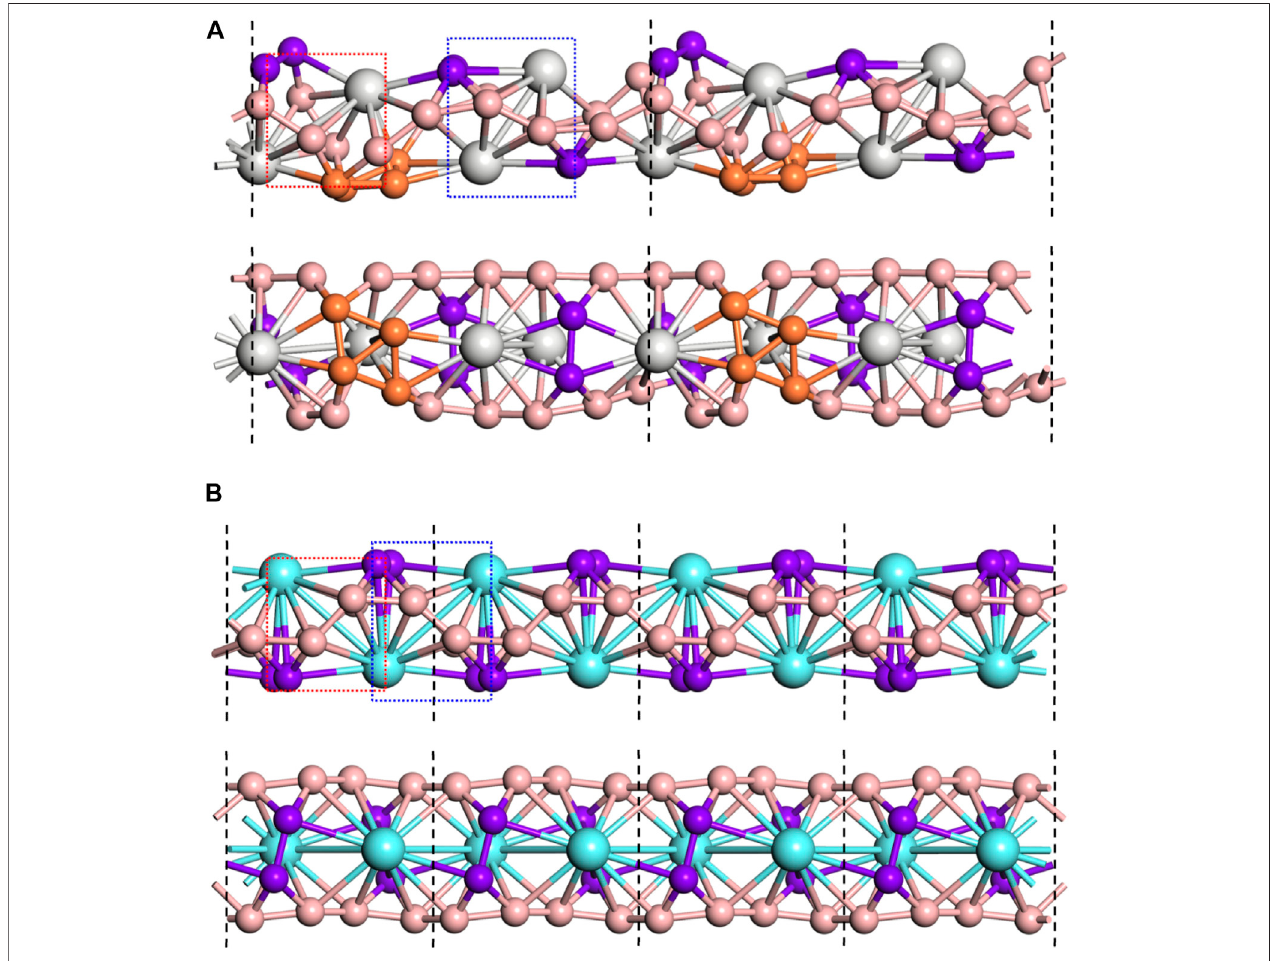
FIGURE 2 | Two views of the 1D-Sc 4 B 24 NW (A) and 1D-Y 2 B 12 NW (B) . The unitcell was marked by black dashed lines. The inverse sandwich unit M 2 B 8 was marked by red and blue dashed rectangle. The sharing B ‒ B bonds and the B rhombus were highlighted in purple and orange, respectively.